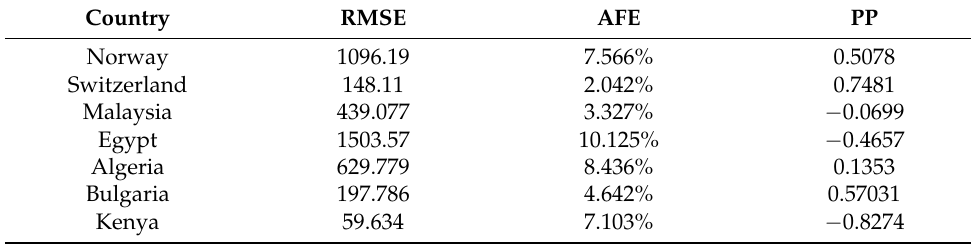
Table 2. Forecasting results for the ANFIS